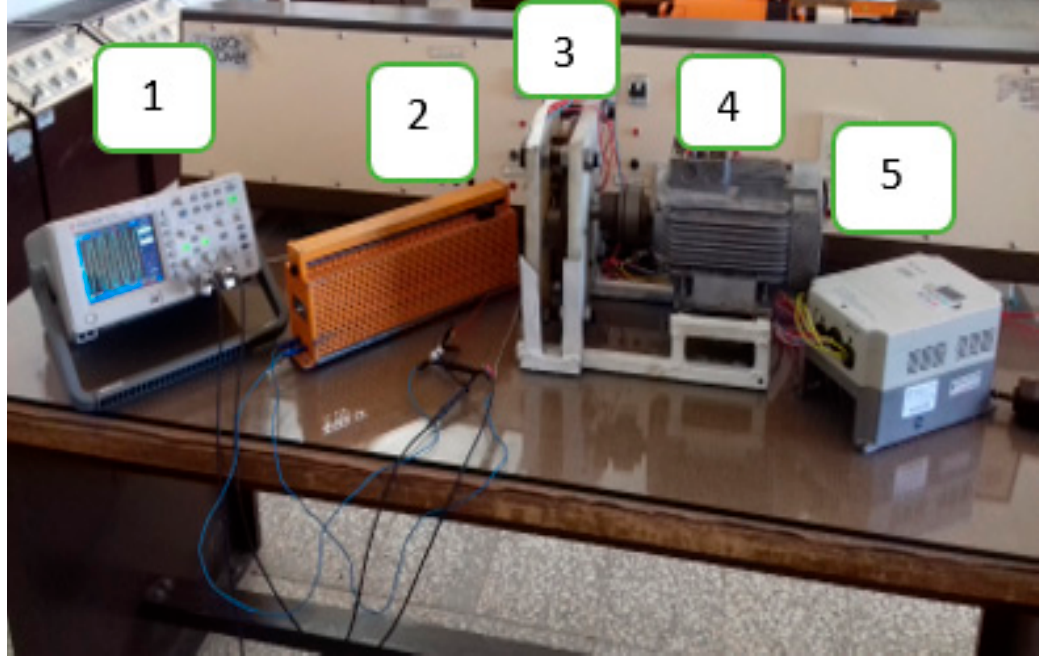
Figure 16. ( 1 ) Oscilloscope; ( 2 ) resistive load; ( 3 ) TFPMDEIG; ( 4 ) asynchronous motor; ( 5 ) inverter drive (VFD). The no-load voltage curve, output voltage curve, output current curve, and output power curves at full load, are plotted in Figure 17.